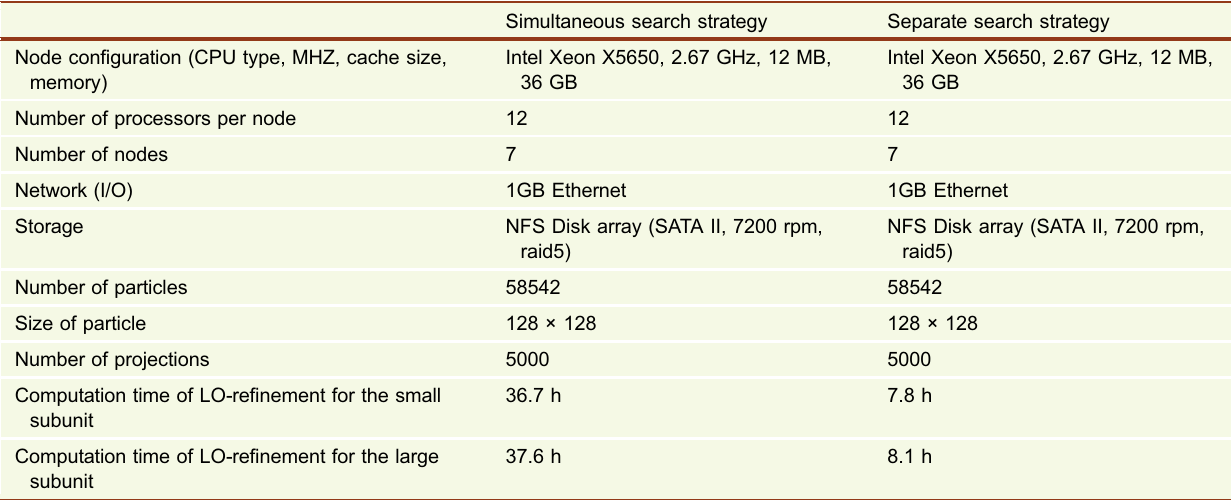
Table 2. Computation consumptions during optimizing parameters of the InSilicoTEM generated dataset for the two parameter- searching strategies Simultaneous search